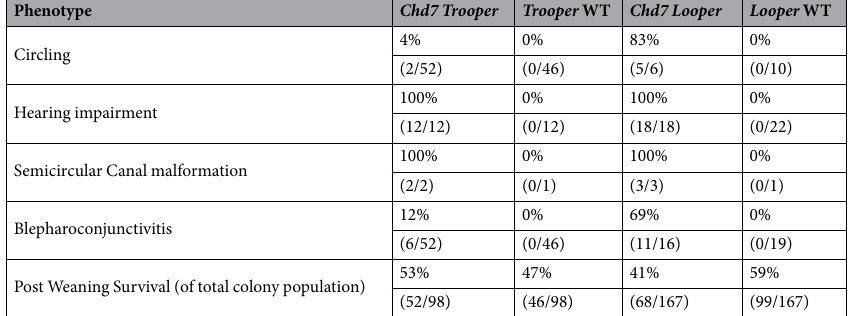
Table 1. Penetrance of Trooper pathology compared with Looper pathology. The Trooper phenotype is milder than previously reported Chd7 mouse mutants.